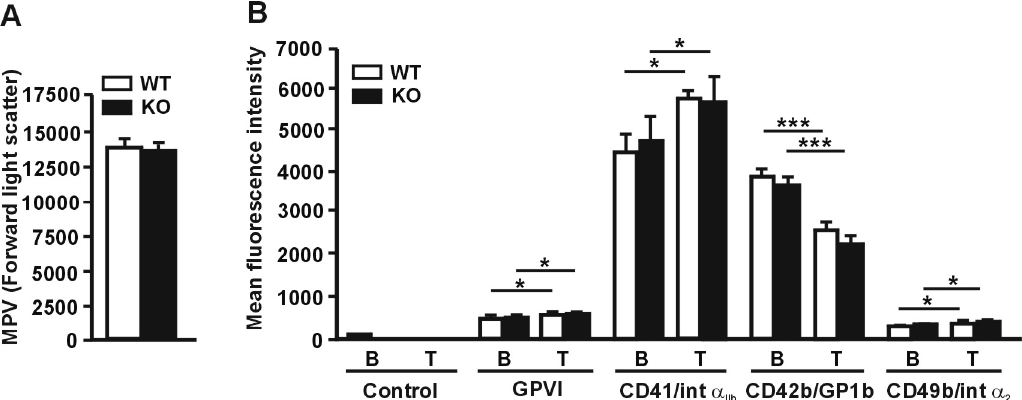
Figure 2. Relative size and receptor expression in RhoBTB3 deficient platelets. ( A ) Mean platelet volume (MPV) was measured by median forward light scatter height using flow cytometry. Data represents average ± SEM of 6 independent experiments. ( B ) Platelet surface receptors were determined by flow cytometry both in basal conditions (B) and upon stimulation with 0.1 U/mL thrombin for 20 minutes. Data represents average ± SEM of 6 independent experiments. * p < 0.05; *** p < 0.001; paired Student’s t ‐ test between basal and stimulated conditions. No significant differences were observed between WT and KO platelets (non ‐ paired Student’s t ‐ test).